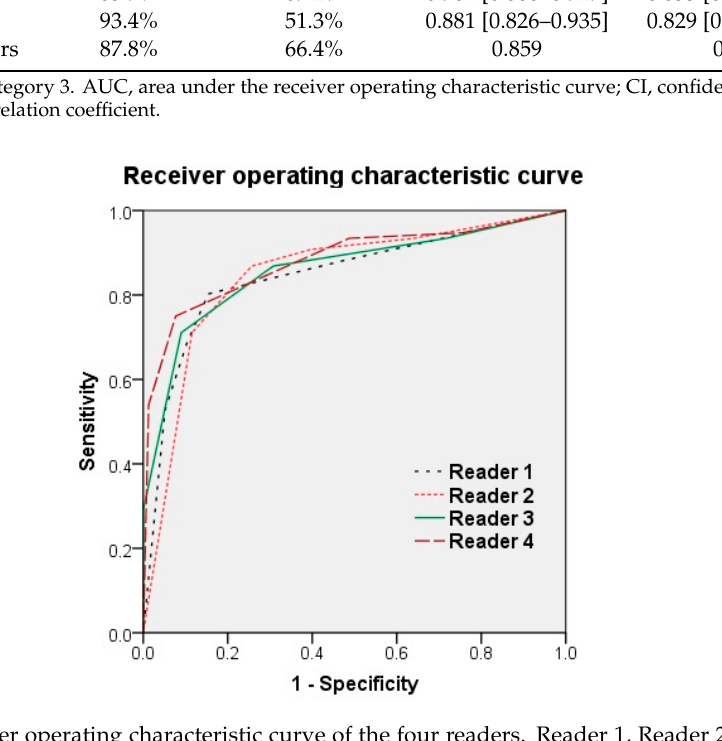
Figure 1. Receiver operating characteristic curve of the four readers. Reader 1, Reader 2, Reader 3, and Reader 4 had an area under the ROC curve (AUC) of 0.847, 0.849, 0.859, and 0.881, respectively. Although the AUC tended to increase with years of radiology experience, there was no significant difference between the readers ( p > 0.200).